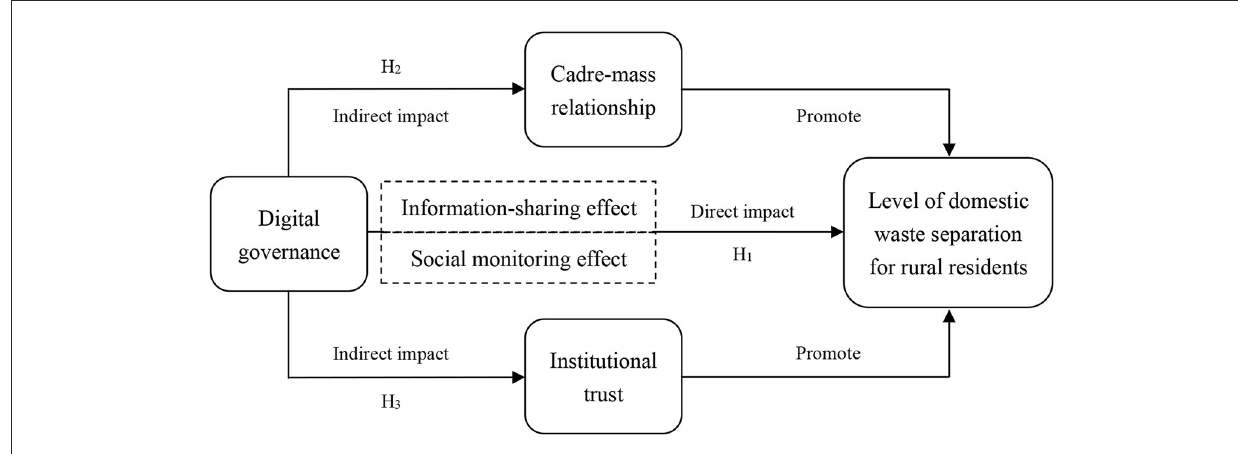
FIGURE1 Mechanisms of the impact of digital governance on the level of domestic waste separation for rural